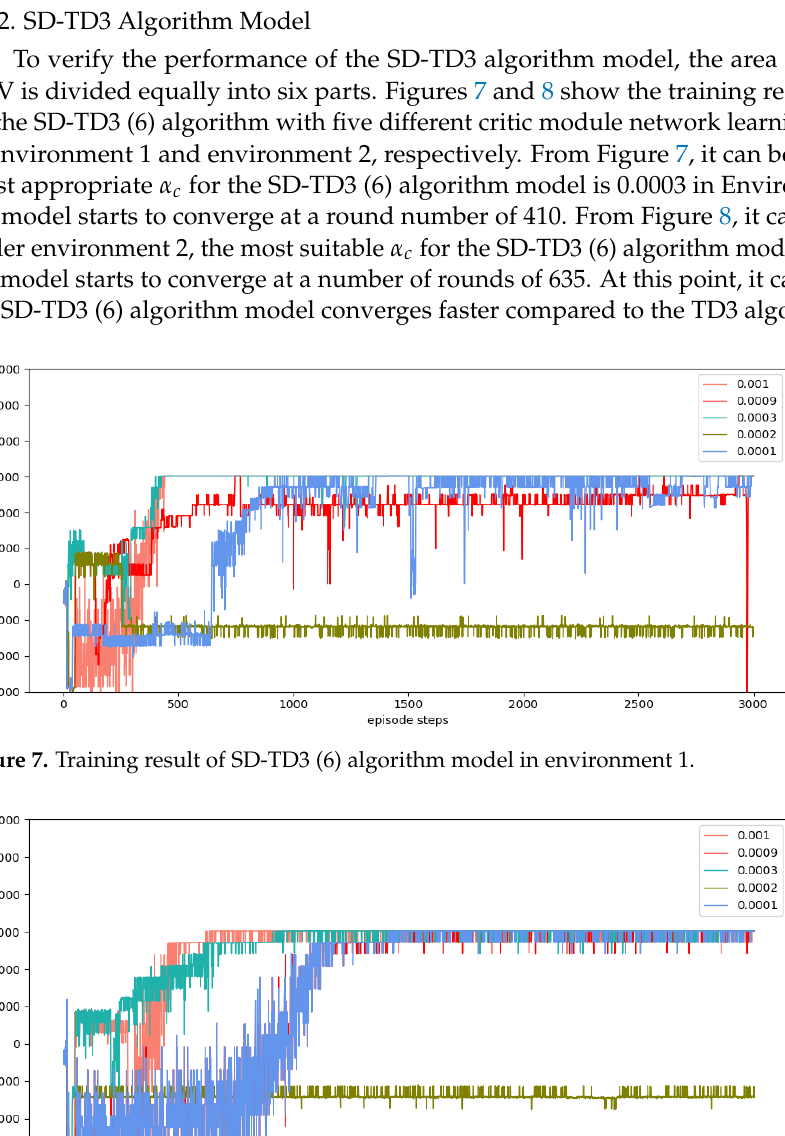
Figure 6. Training result of TD3 algorithm model in environment 2.